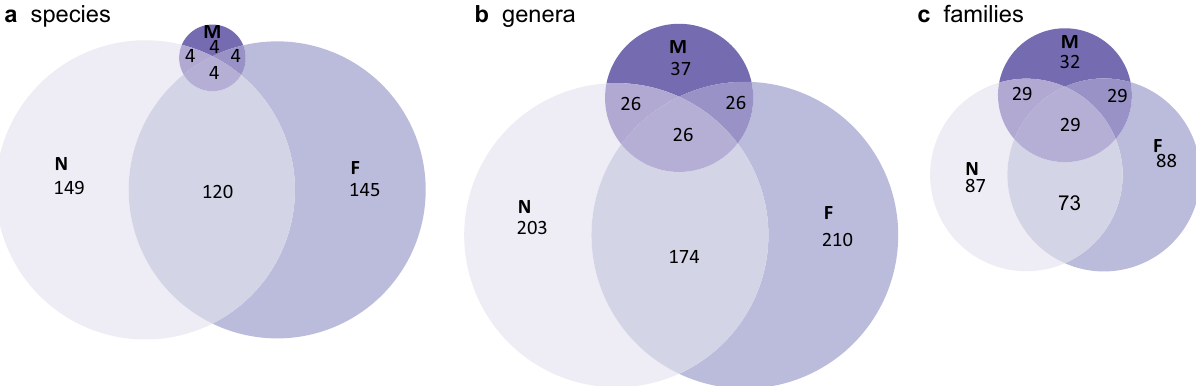
Figure 6. Euler diagrams showing the total number of plant taxa identified from all the samples by morphological identification of pollen (M) and metabarcoding (combined from ITS2, rbc L a and trn L gene regions) of the non-filtered (N) and filtered (F) subsamples as well as the number of shared and unique plant taxa, at different taxonomic levels, for (a) species, (b) genera and (c) families (Supplementary Table S20). The sizes of the graphs are drawn in proportion to the number of